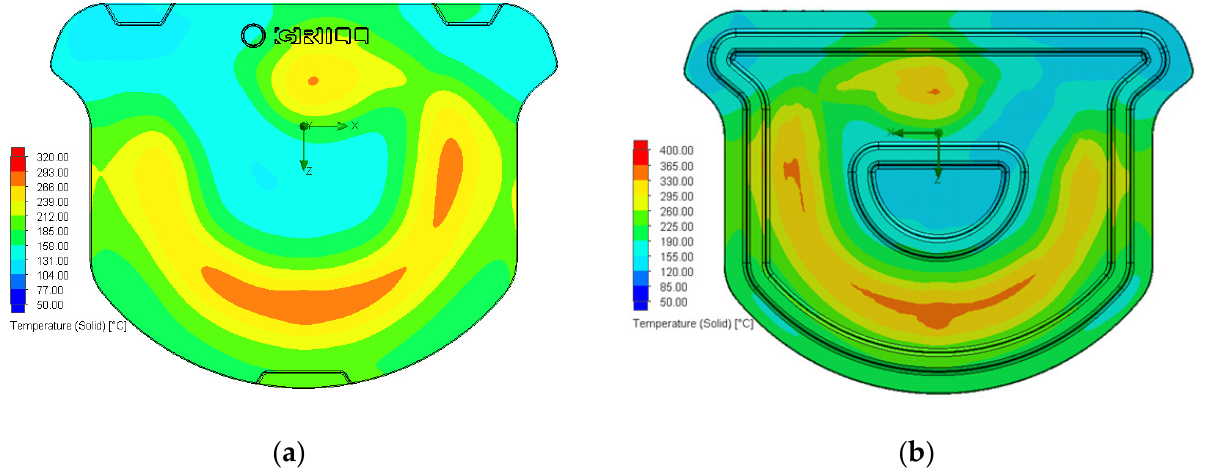
Figure 14. Temperature distribution on the ( a ) surface and ( b ) bottom of the CA#3 stone grill plate.